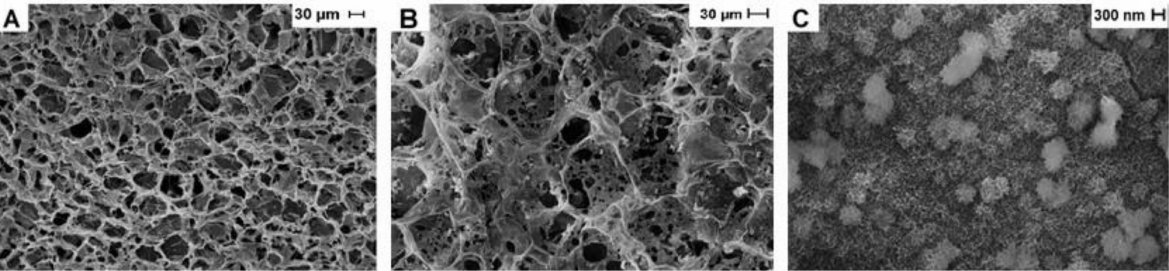
Figure 3. SEM images of ( A ), CN25; ( B ), CN25M at 500 × magnification. In ( C ), CN25M at 25,000 × magnification.